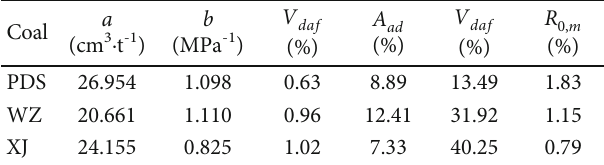
Table 1: Industrial analysis for experimental coal